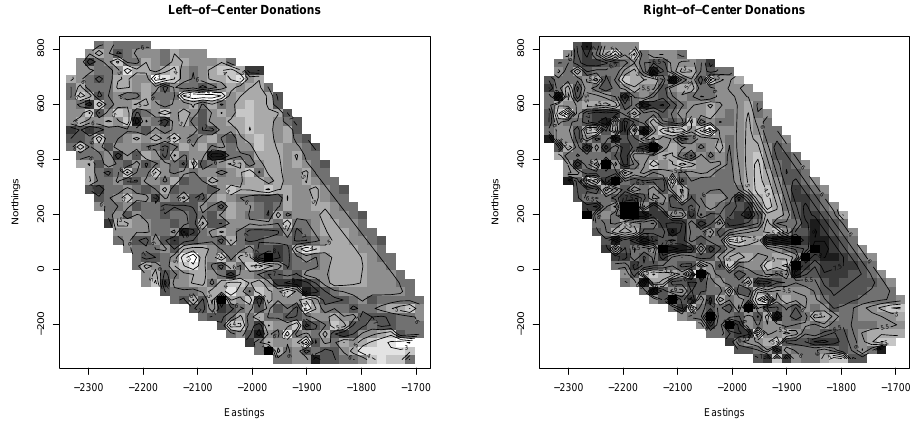
Figure 6. Contour Maps of Left- and Right-of-Center